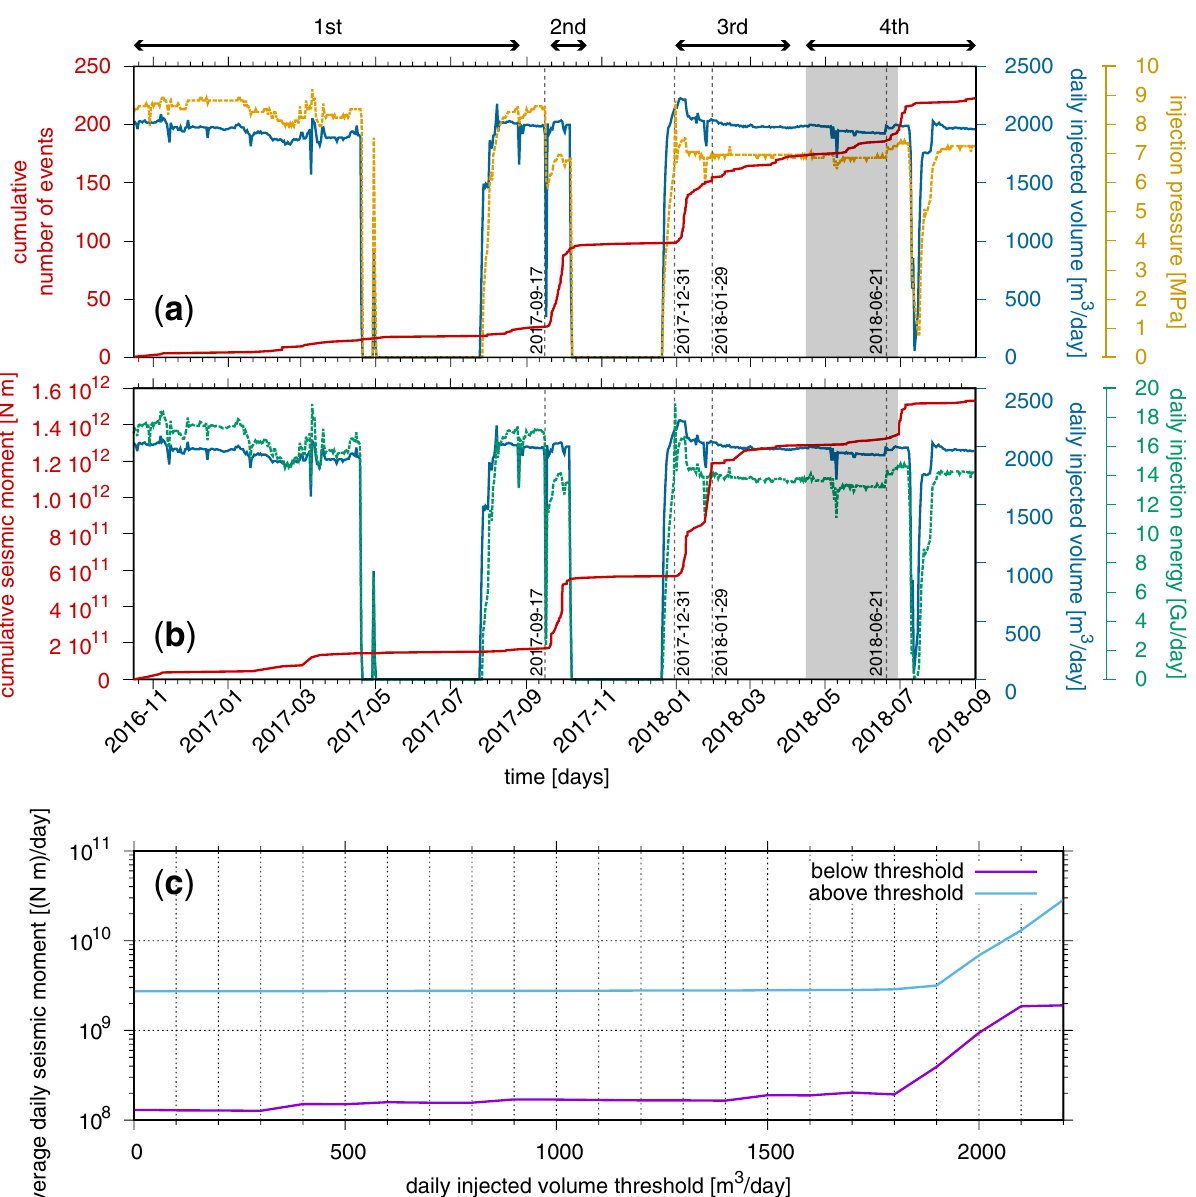
Figure 5. ( a , b ) Wellhead operational parameters against the cumulative number of induced events (including those only detected) and the cumulative seismic moment of located events during time. ( a ) Cumulative number of events (solid red line) against the average fluid injection pressure (dashed yellow line) and the daily injected volumes (solid blue line). ( b ) Cumulative seismic moment of events (solid red line) against the daily fluid injection energy (dashed green line) and again the daily injected volumes (solid blue line). The four periods of time where the seismicity shows different space–time characteristics are indicated on the top of the panels by means of black double-ended arrows. Crucial dates are indicated with vertical dashed grey lines. ( c ) Average daily seismic moment of events occurred above (cyan line) and below (violet line) a given injection rate threshold as a function of the daily injection rate